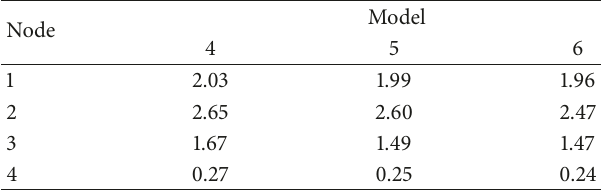
Table 6: Maximum displacements (mm) elicited by the three